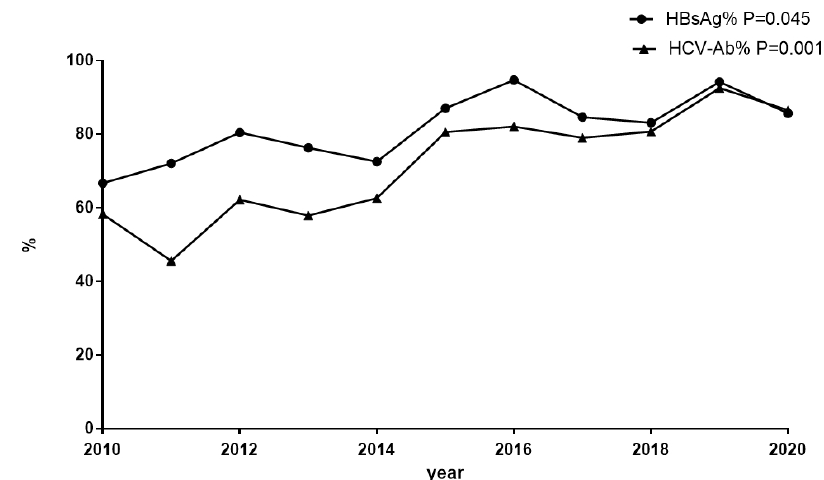
Figure 1. Trend analysis based on a linear-by-linear association test for the screening proportions of HBsAg and anti-HCV. The screening proportions of HBsAg and anti-HCV showed an ascending trend among the HIV-positive inpatients in the past several years. HBsAg: the screening proportion of HBsAg among HIV-positive inpatients. HCV-Ab: the screening proportion of anti-HCV among HIV-positive in patients.